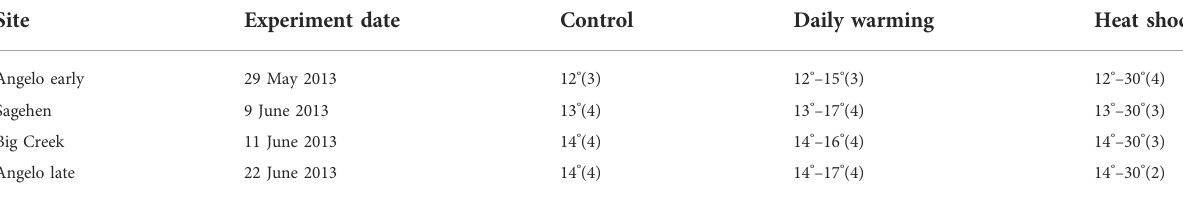
TABLE 2 Experimental temperatures treatments ( ° C) and number of individuals analyzed in